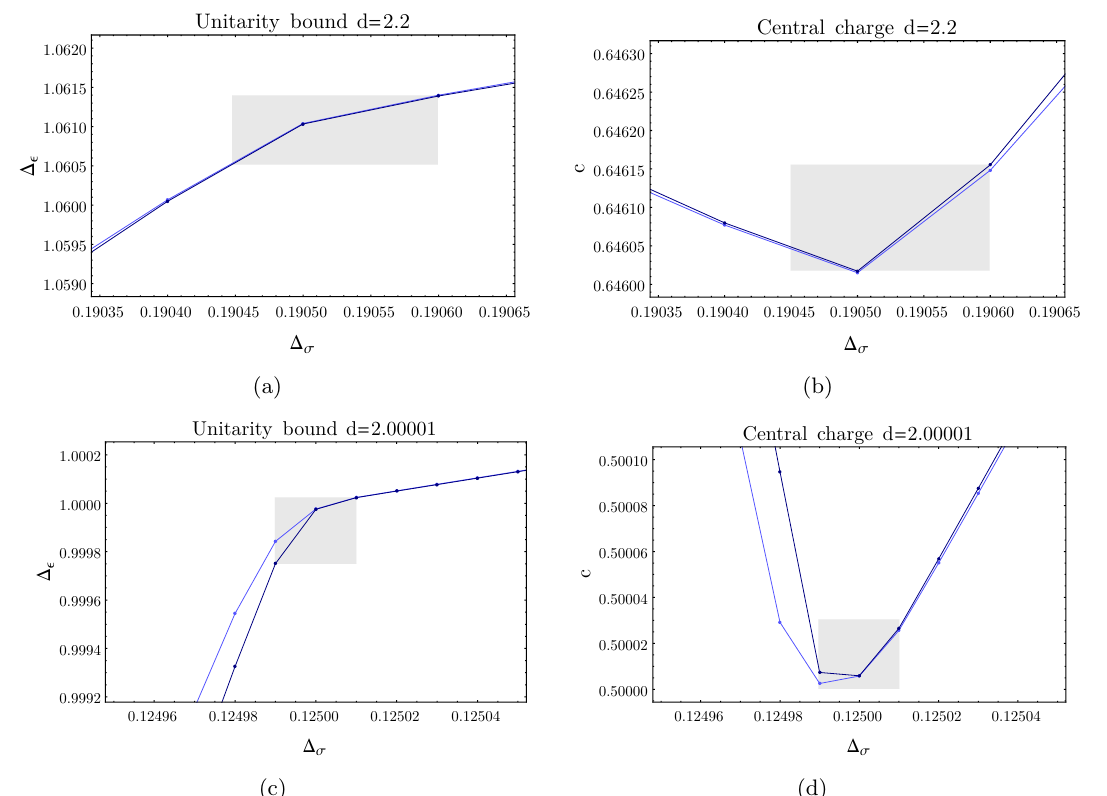
Figure 3 . Determination of the Ising critical point for d = 2 : 2 (smaller scale) and d = 2 : 00001.